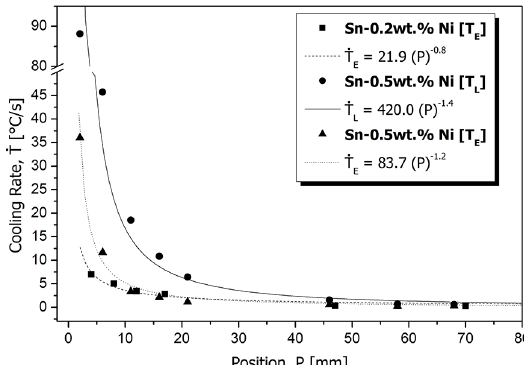
Figure 3. Experimental plots of eutectic cooling rates and tip cooling rates for: Sn-0.2 and 0.5 wt.%Ni alloys along the length of the directionally solidified castings